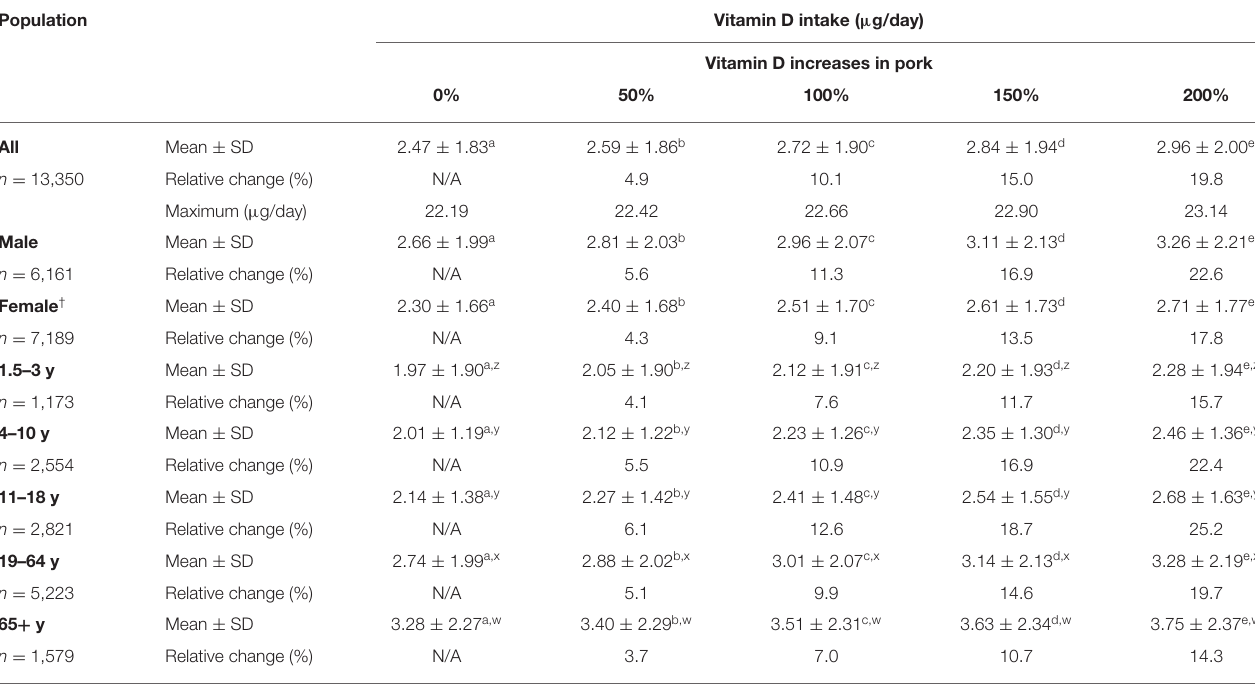
TABLE 2 | Theoretical mean vitamin D intakes ( µ g/day), split by gender and age ranges, from diet alone of UK population in response to varying increases in vitamin D concentration of pork and pork products ( n = 13,350).